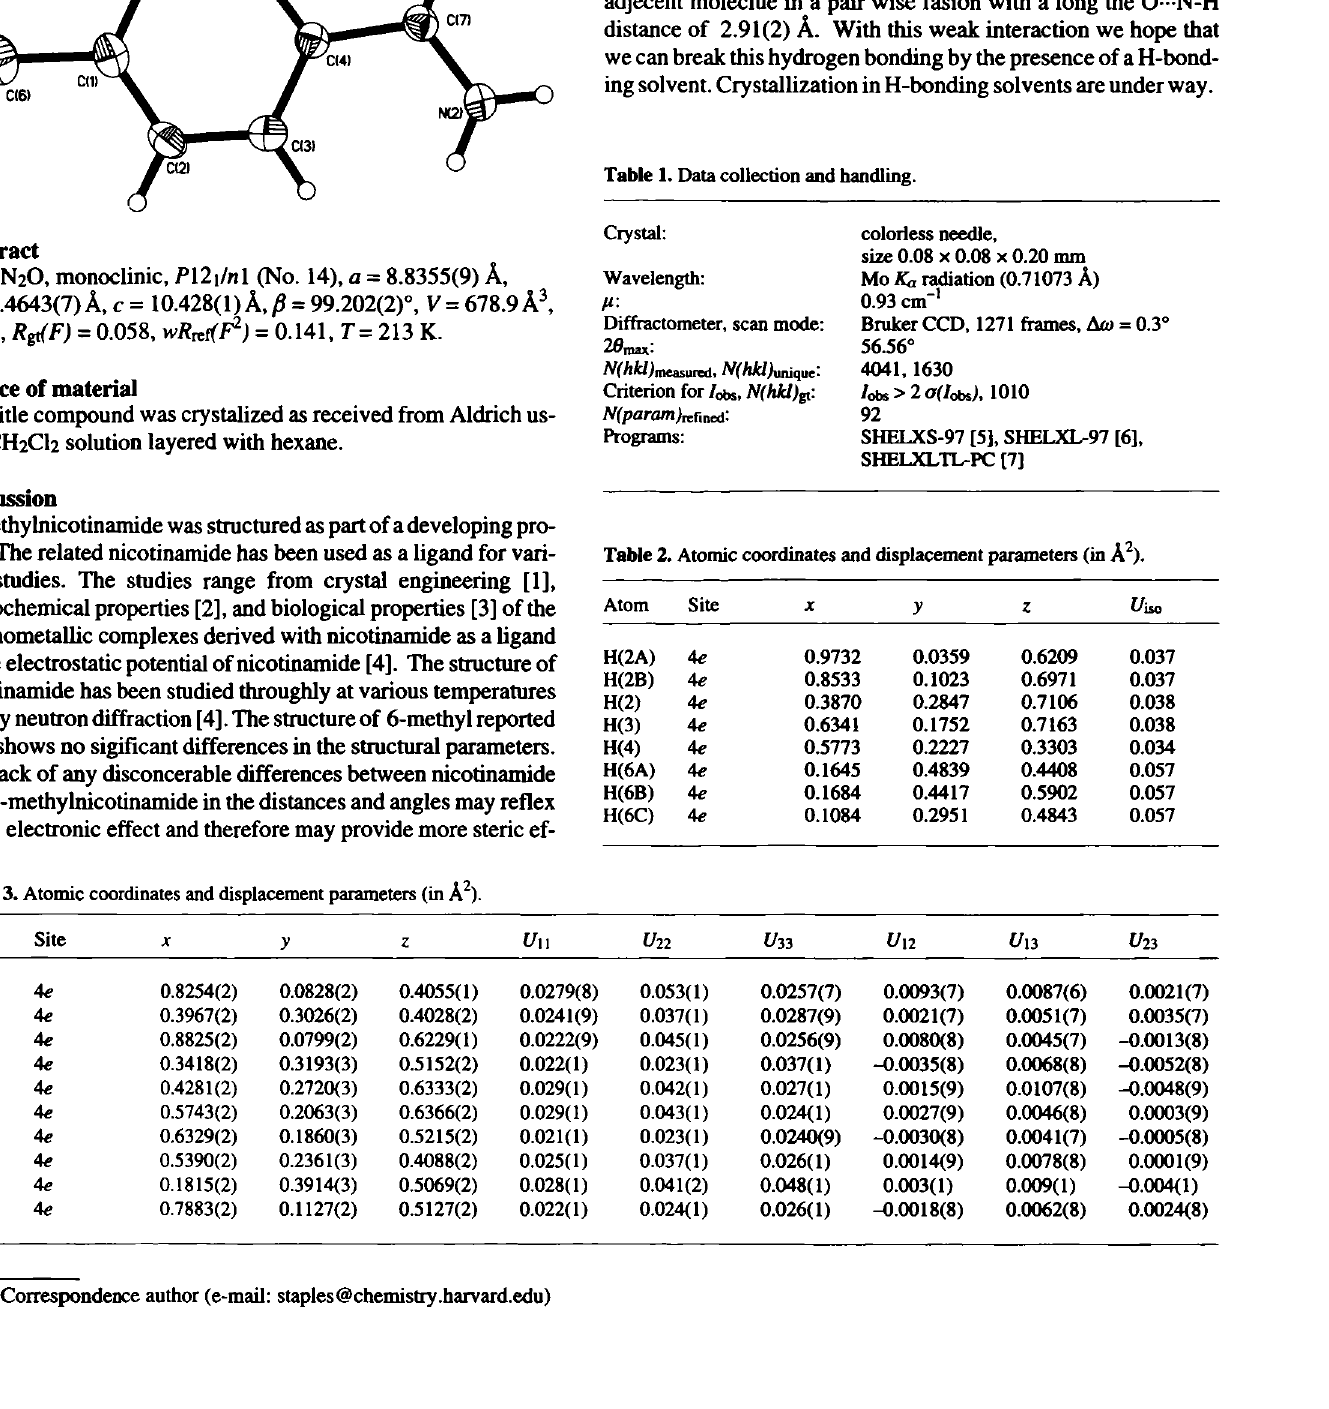
Table 1. Data collection and handling.